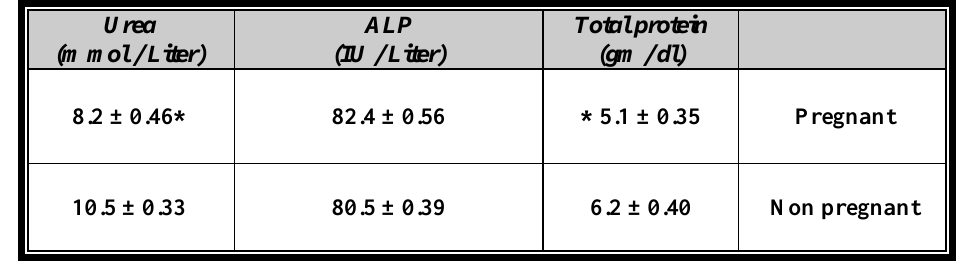
Table (3) The effect of pregnancy on biochemical parameters (total protein , ALP and urea) . Urea